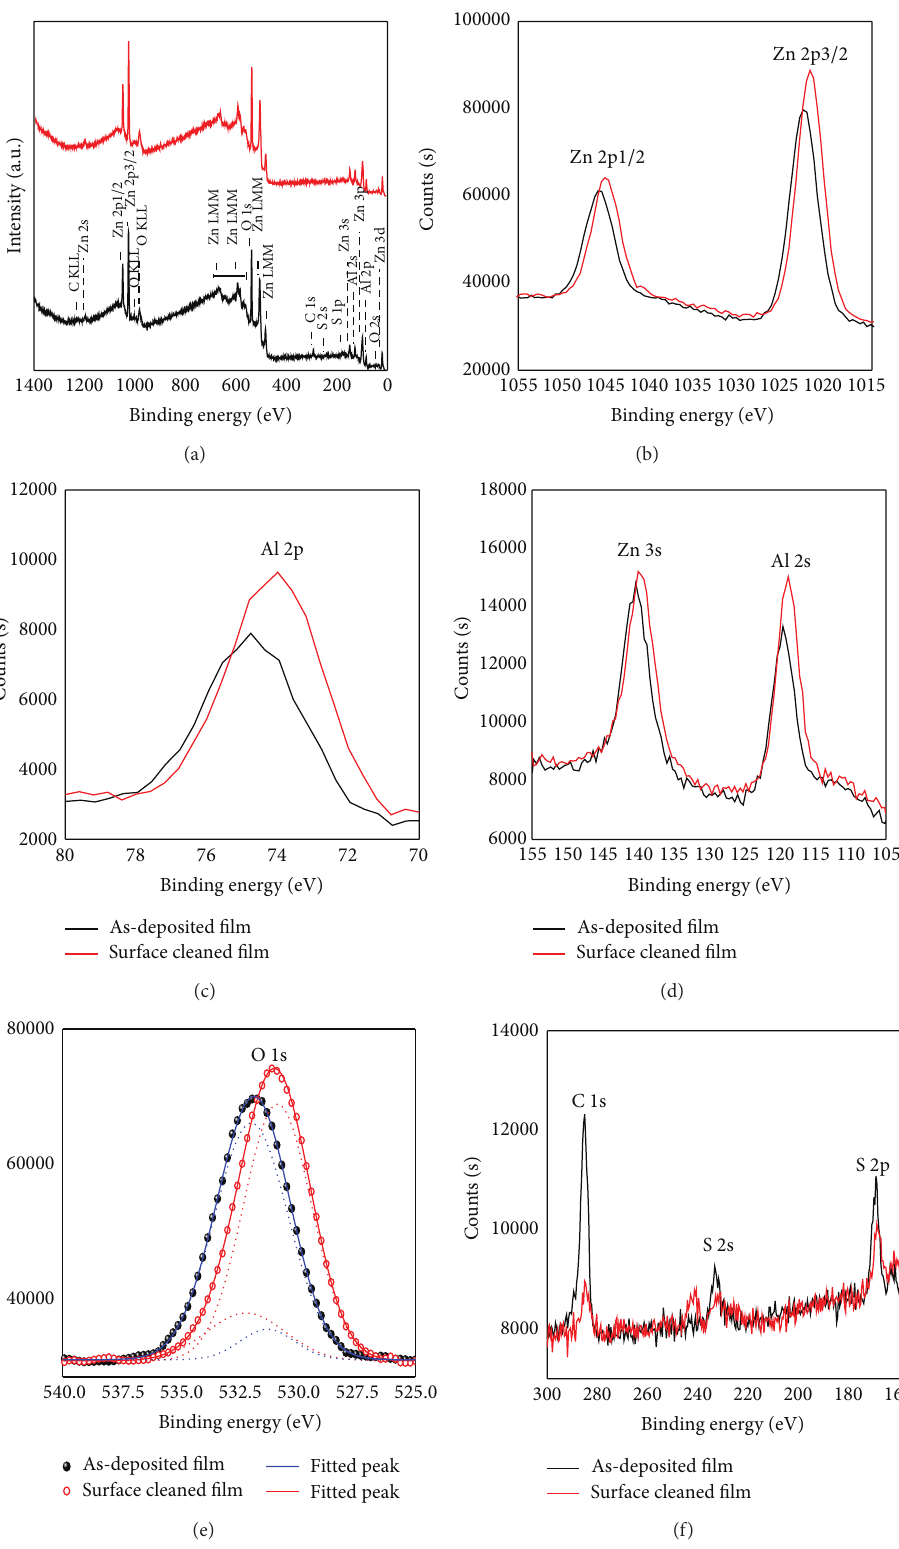
Figure 6: XPS survey spectra of the ZnO/ZnAl 2 O 4 as-deposited (black line) and sputter-cleaned (red line) films treated at 700 ∘ C for 1h (a), Zn 2p XPS spectrum (b), Al 2p XPS spectrum (c), Al 2s and Zn 3s XPS spectrum (d), O 1s XPS spectrum (e), and C 1s, S 2p, and S 2s XPS spectrum (f) of the